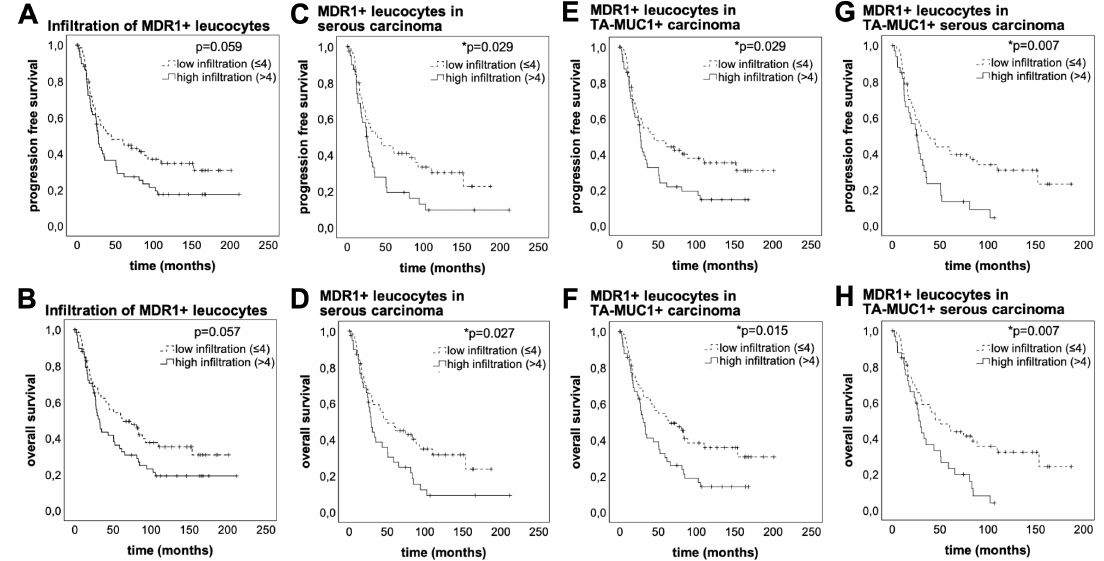
Figure 3. A high MDR1 + leucocyte infiltrate is associated with poor prognosis especially in patients whose carcinoma shows serous histology and TA-MUC1 expression. The Kaplan-Meier estimates show that high MDR1 + leucocyte infiltration ( > 4/field of view, 25 × lens) leads to decreased PFS ( A , p = 0.059, n = 126) and OS ( A , p = 0.057, n = 126), although not statistically significant. Late separation of the curves suggests long time effects mediated by the MDR1 + leucocyte infiltrate. In serous subtype these effects lead to significantly impaired PFS ( p = 0.029, n = 91) and OS ( p = 0.027, n = 91). ( E – H ) show combined survival analysis of a high MDR1 + leucocyte infiltrate and TA-MUC1. PFS (E, p = 0.029, n = 110) and OS (F, p = 0.015, n = 110) of patients with high MDR1 + leucocyte infiltration is significantly decreased in TA-MUC1 + cases (IRS > 0), which are even worse when the carcinoma shows also serous histology (G, PFS, p = 0.007, n = 81; H, OS p = 0.007, n = 81). Censoring events have been marked in the graphs ( +